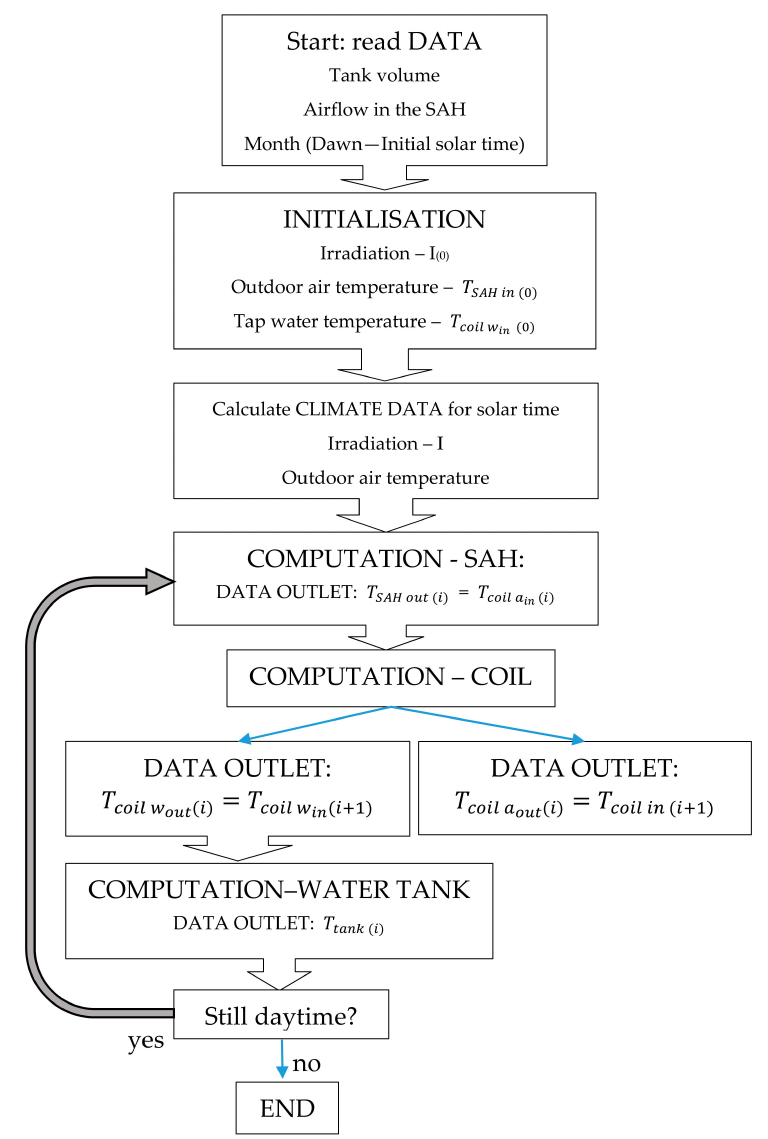
Figure 7. Flowchart showing the computation